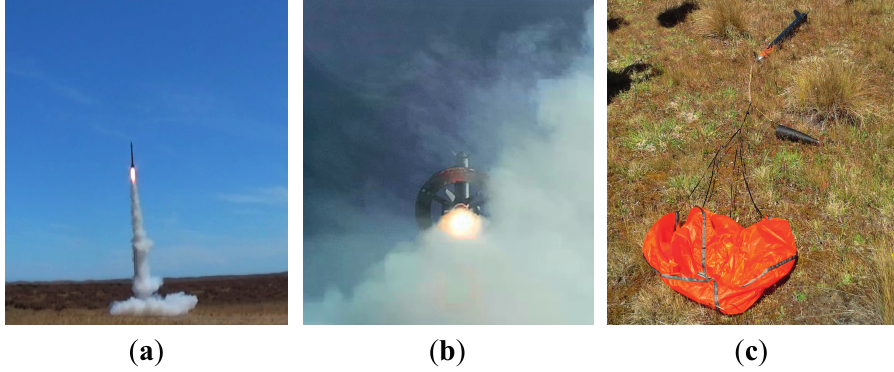
Figure 19. Smokey leaving launch guide ( a ) video still; ( b ) Mobius on launch guide; ( c ) Successfully recovered rocket.